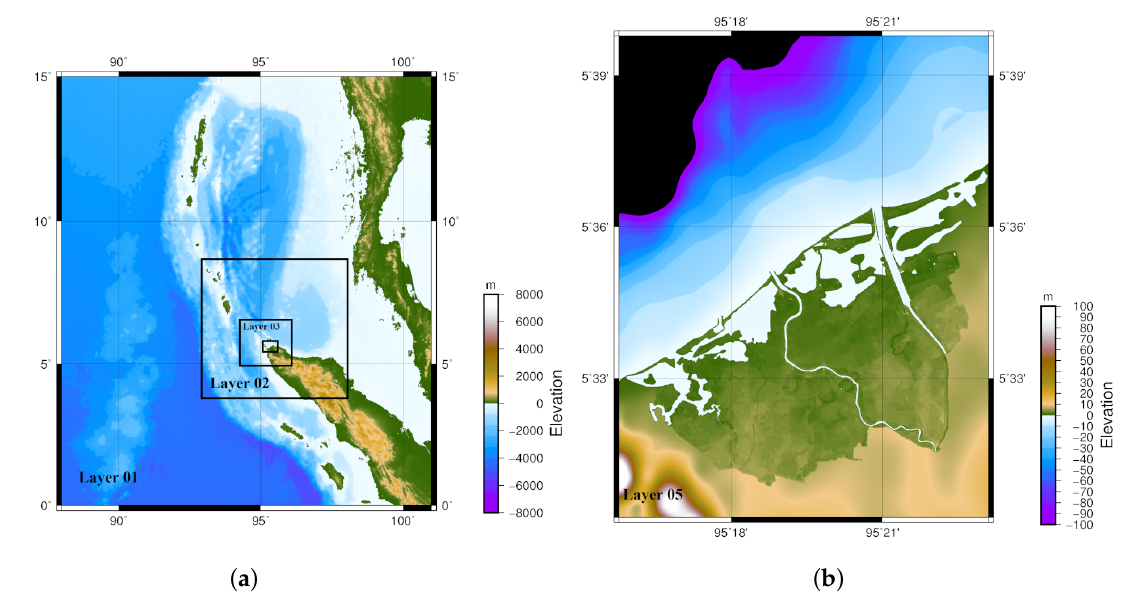
Figure 3. Nested grids for the Cornell Multigrid Coupled Tsunami Model coupled with a sediment module (COMCOT-SED) simulation domain showing ( a ) Layers 1–4 and ( b ) Layer 5.